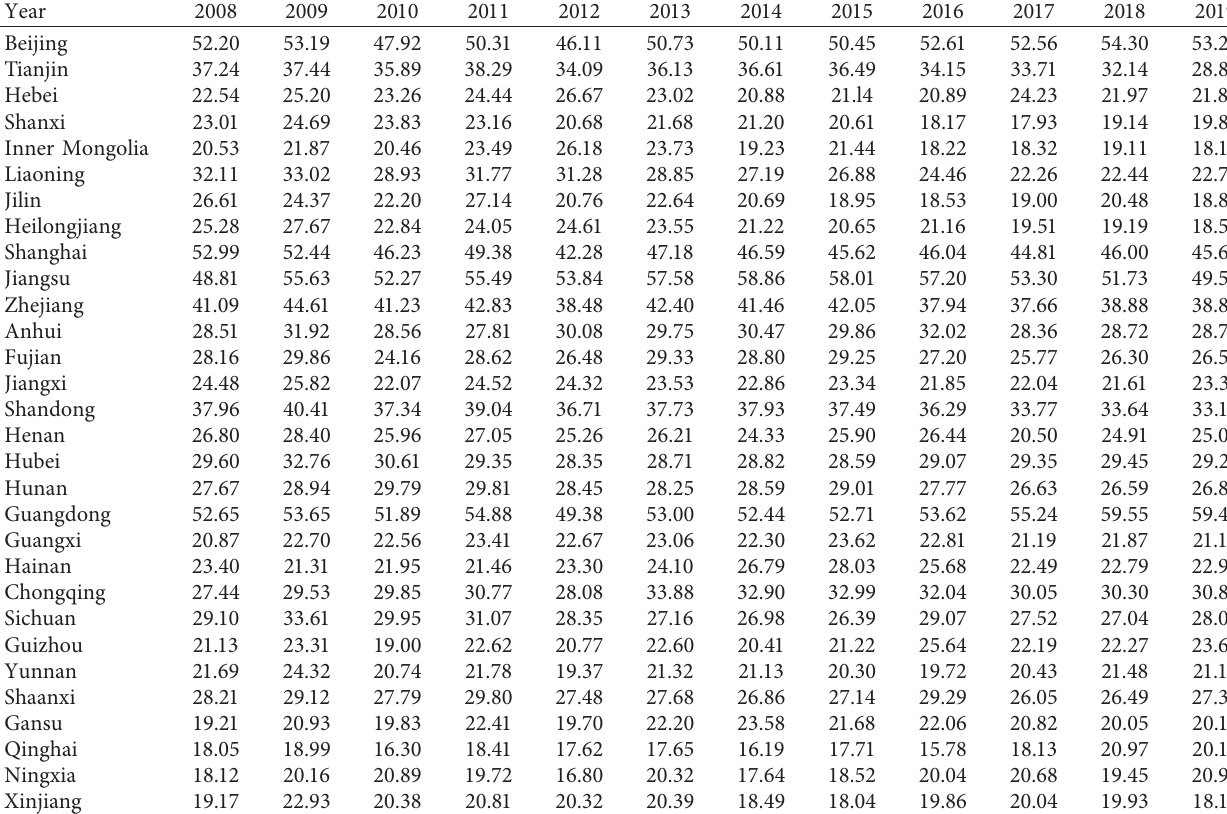
Table 5: Evaluation scores of the urban innovation level of 30 provinces and cities in China.